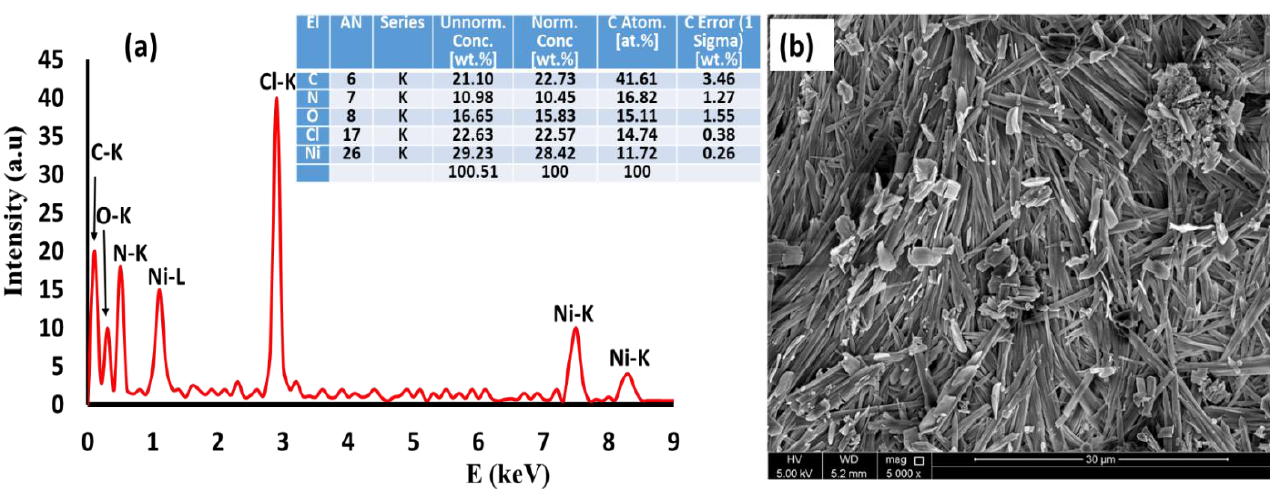
Figure 1. ( a ) EDX and ( b ) SEM (μm) of {[Ni(tptz)Cl(H 2 O) 2 ][Ni(tptz)(H 2 O) 3 ]}3Cl.5H 2 O complex.